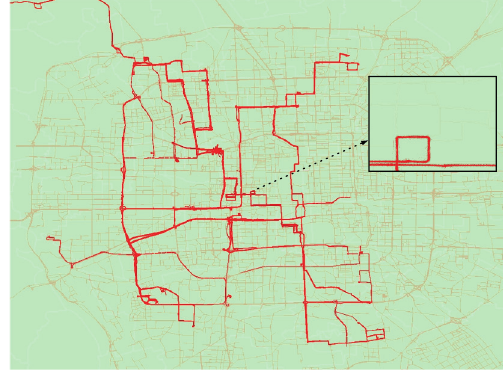
Figure 2: GPS data matching with GIS.